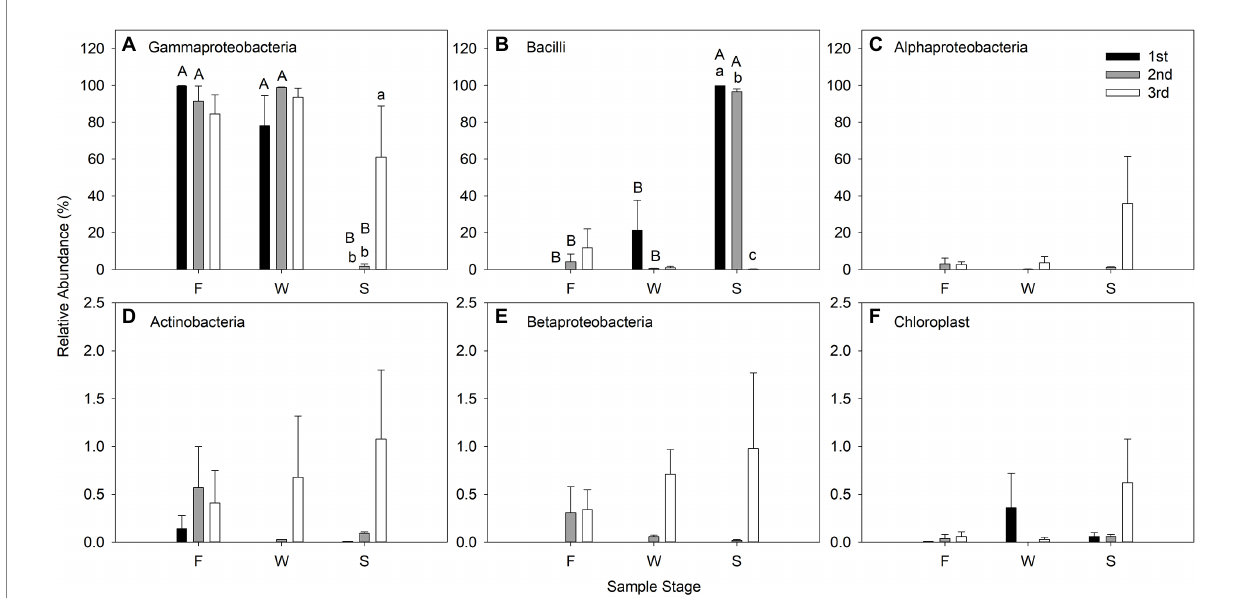
FIGURE 4 Relative abundance (% of individual taxonomic group) of dominant bacteria classes (mean ± SE, n = 3) in microbial communities following fresh alfalfa (F), wilted alfalfa (W) and ensiled alfalfa (S) at different cuttings. The black filled bar indicate the first cutting alfalfa, the gray filled bar indicted the second cutting alfalfa, and the non-filled bar indicate the third cutting alfalfa. Bar with different capital letters differ among F, W, and S in the same cutting; Bar with different lowercase letters differ among different cuttings p =